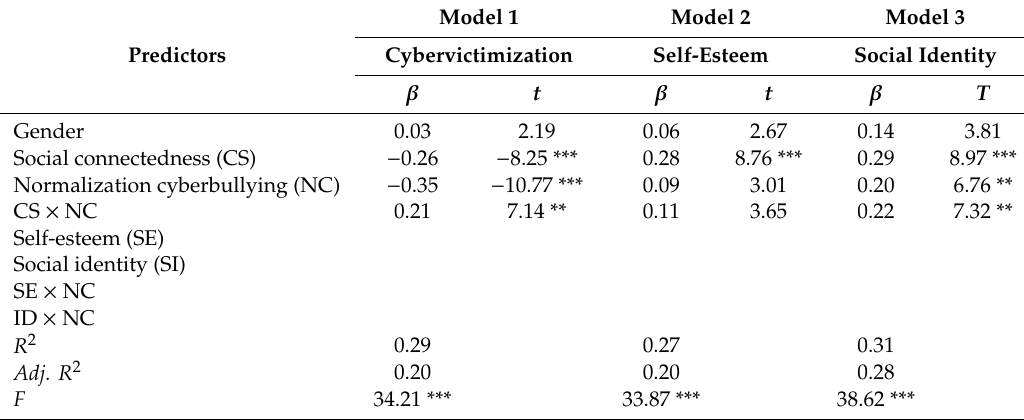
Table 4. Coe ffi cients of the moderated mediation